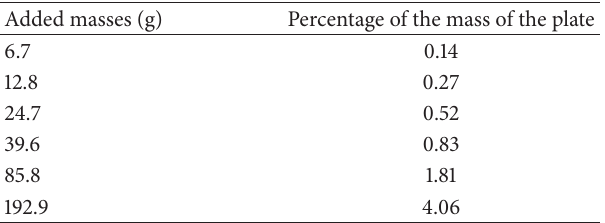
Table 3: Added masses and comparison with the total mass of the